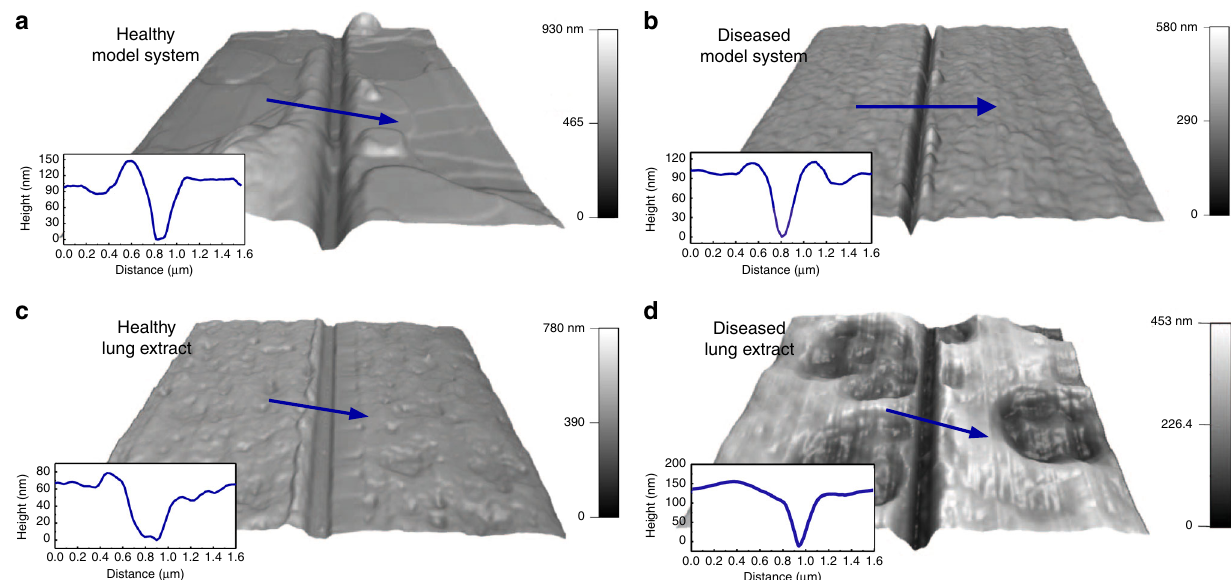
Fig. 3 Film thickness of model systems and lung extracts. AFM 3D height images and cross-sectional pro fi les of a healthy model systems composed of 3:1 DPPC:DOPG, scan size 4 μ m × 4 μ m, b diseased model system consisting of 3:1 DPPC:DOPG with addition of cardiolipin and Ca 2 þ , scan size 8 μ m × 8 μ m, c healthy bovine lipid – protein extract surfactant (BLES), scan size 11 μ m x 11 μ m, and d diseased BLES with cardiolipin and Ca 2 þ . Blue arrows display scanning directions of pro fi les, scan size 10 μ m × 10 μ